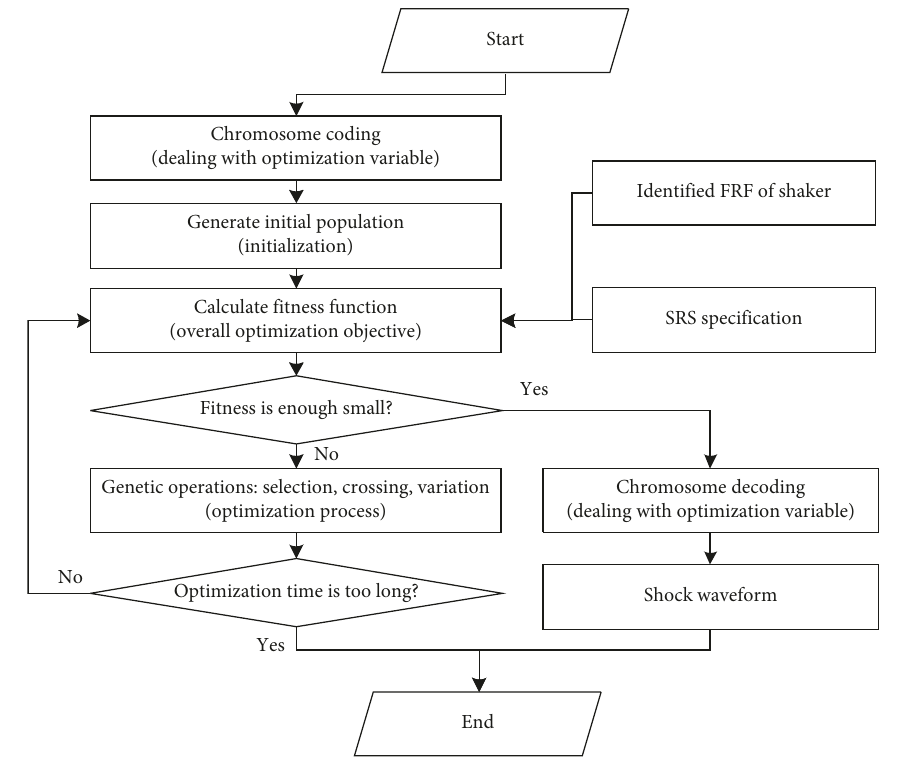
Figure 6: Optimization process using GA.